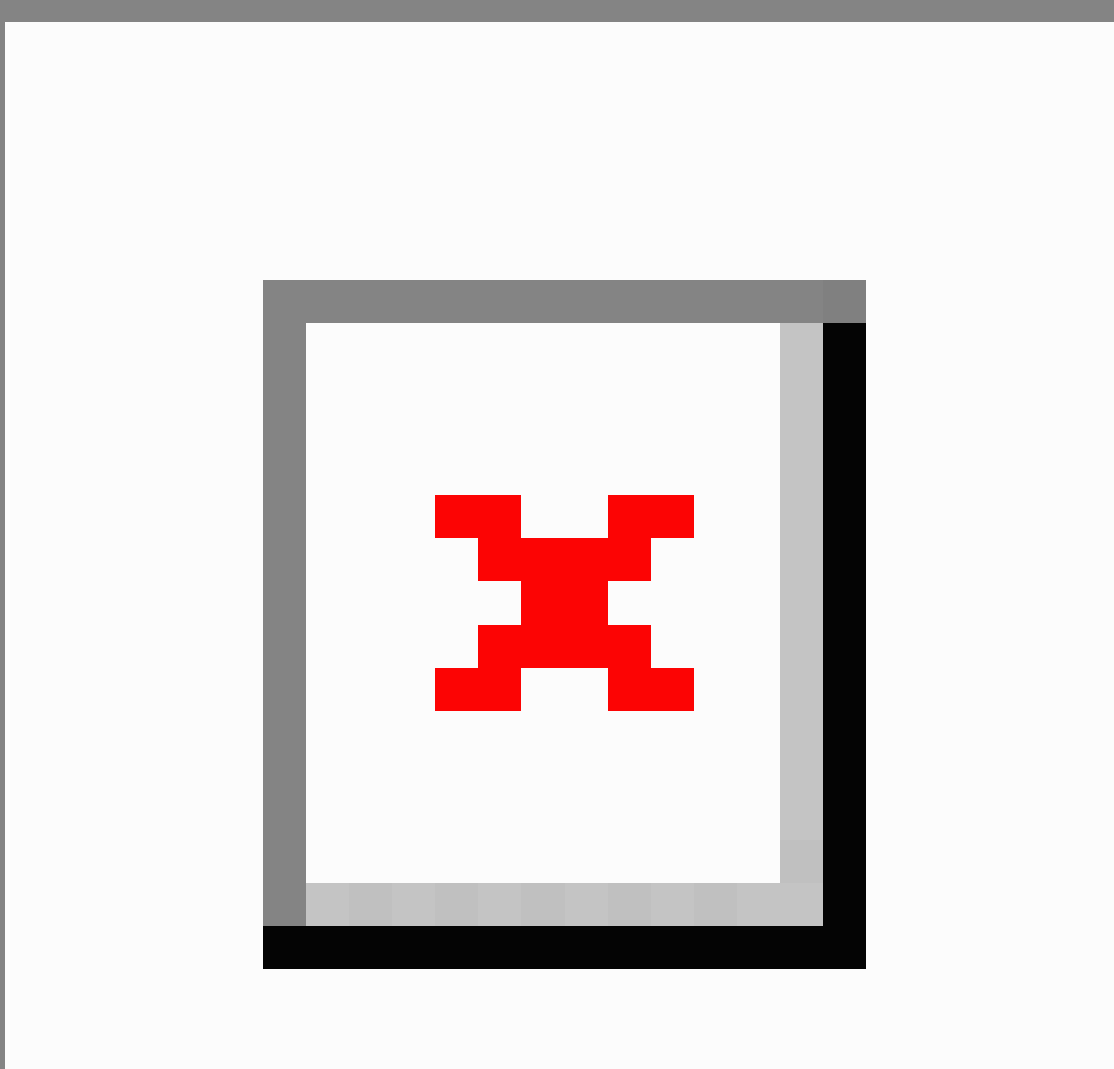
Figure 2. Patient-entered pictures showing left breast of a breast reconstruction patient following insertion of a tissue expander, where the surgeon identified an increasing erythema at 10 days post-op. The sequence of pictures and dates are shown. The patient was placed on antibiotics (over the phone) on Dec. 28th and the erythema starts to recede. The camera quality on most mobile phones is capable of detecting subtle changes in skin